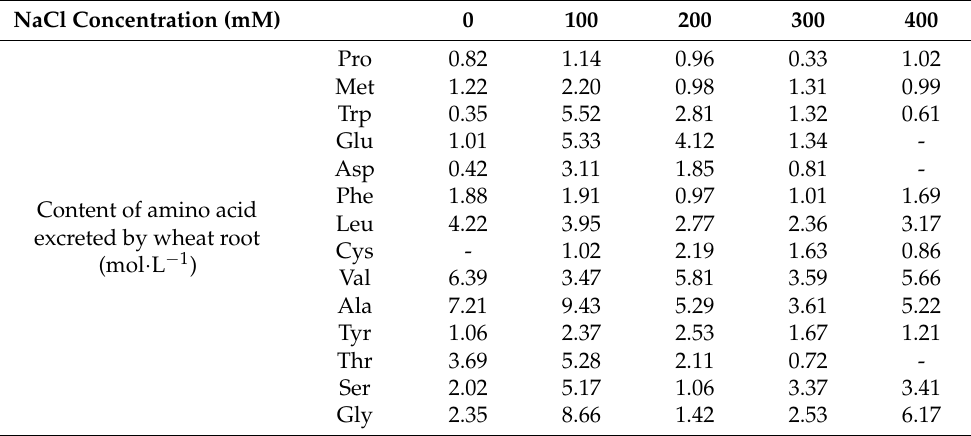
Table 1. Effect of NaCl on amino acid excreted by wheat root.